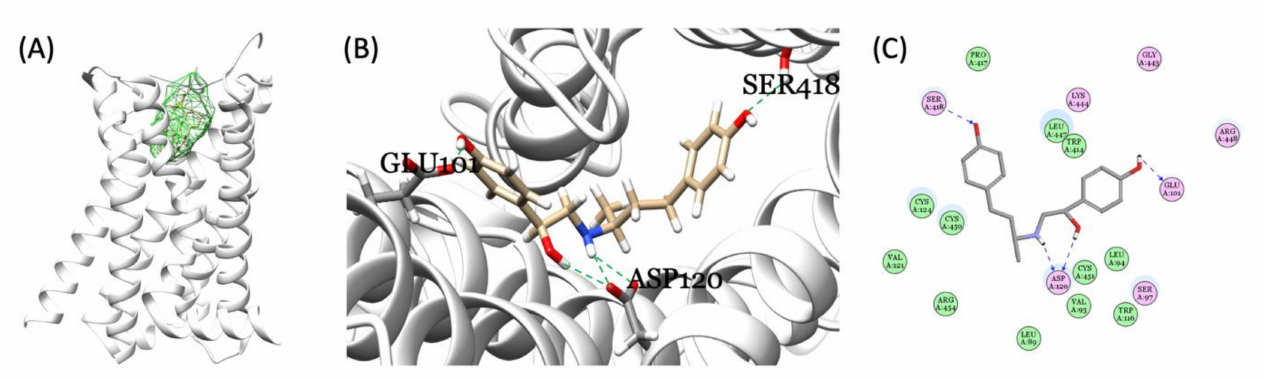
Figure 6. Molecular docking of RAC and zebrafish endogenous β -adrenergic receptor. ( A ) The identified binding pocket in the middle of the hollow cylinder of the seven transmembrane domain sub-types homology modeling structures of β -adrenergic receptor (adra1aa as an example). Three-dimensional (3D) ( B ) and 2D ( C ) illustrations of interactions between RAC and endogenous zebrafish β -adrenergic receptor showing the three hydrogen bond formations between RAC and adra1aa at the positions Glu101, Ser418, and Asp120 (highlighted by the green and blue dotted